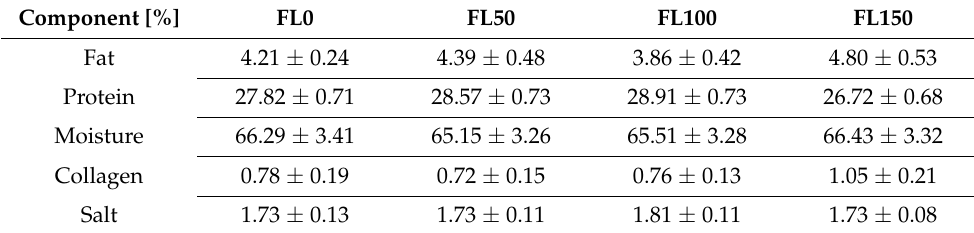
Table 3. Proximate chemical composition of fermented loins (mean ± standard